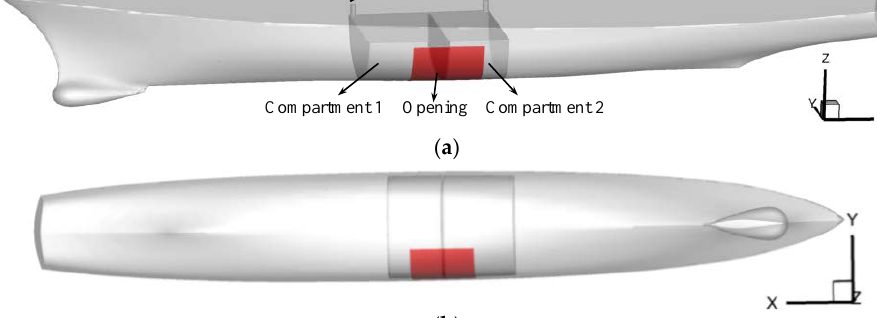
Figure 1. Model of frigate with damaged compartments for symmetrical flooding at different views: ( a ) Side view ( b ) Bottom view.